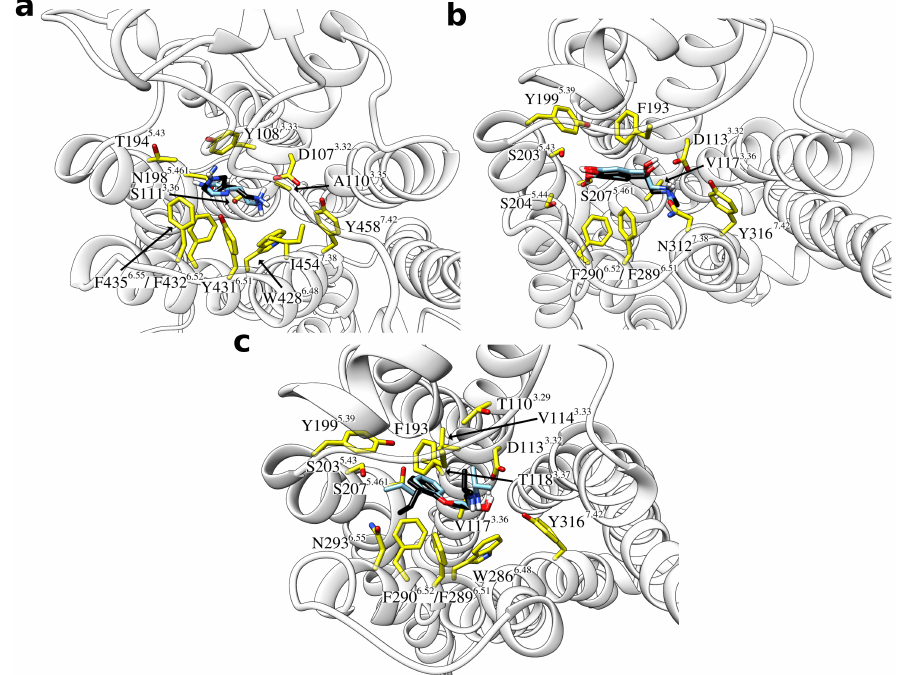
Figure 4. Overlay of the most populated ligand cluster structures and the reference binding mode. The ligands are shown as sticks with the carbon atoms of the reference ligand colored in black and those of the cluster structure in light blue. Interacting residues of the respective GPCR are labeled and shown as yellow sticks. ( a ) Histamine in complex with the H 1 receptor, ( b ) adrenaline, and ( c ) alprenolol both in complex with the β 2 adrenoceptor. Table 3. Clustering of the multiple walker metadynamics trajectories around the free energy minima. The table contains the percentages of those frames within 3 Å around the minima, for which the calculated clusters are representative, and the RMSD values of the cluster structures compared to the reference binding modes. The RMSD values refer to heavy atoms and were calculated both for the ligand and for the residues of the orthosteric binding site, i.e., the residues which are located within 5 Å of the ligand in the reference